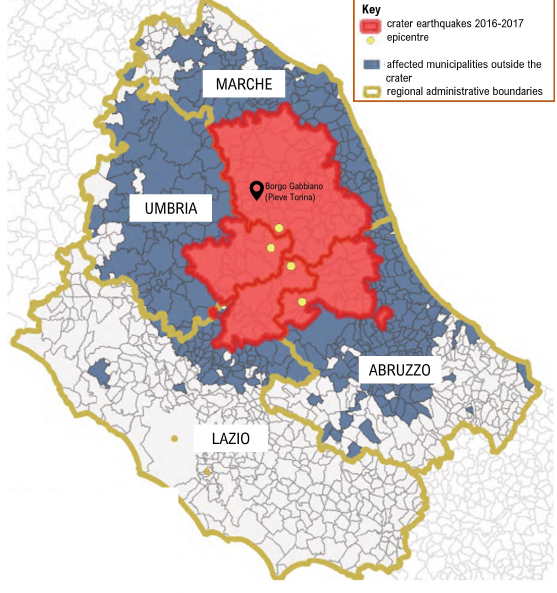
Figure 2. Map of the seismic crater in Central Italy after earthquakes 2016–2017 (source: report curated by Ufficio Speciale Ricostruzione, January 2020) and identification of the site of interest Gabbiano (Pieve Torina, Italy).